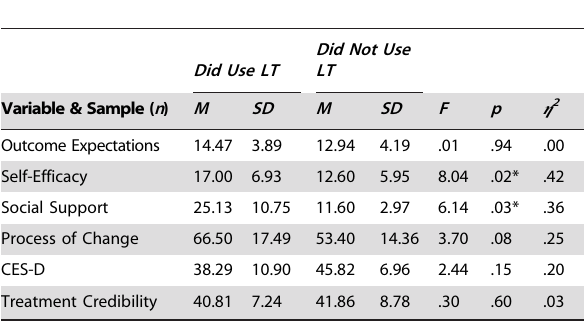
Table 2. MANOVA comparing individuals that did and did not use